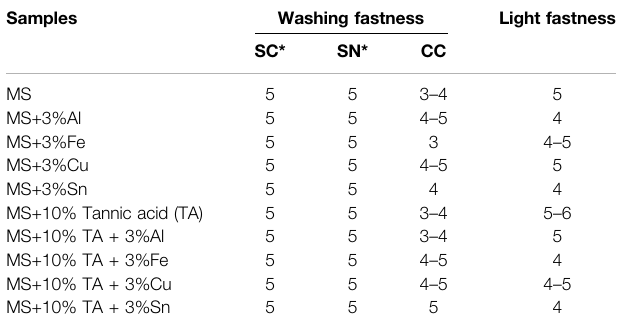
TABLE 2 | Colorimetric data of the cotton fabric with and without mordanting. Samples